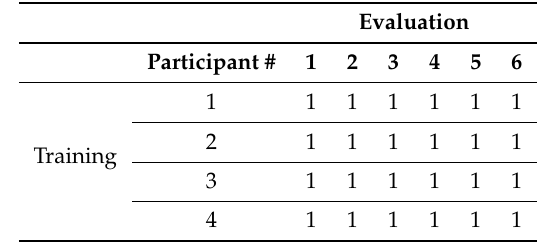
Table 6. Accuracy rates for each combination of training and evaluation participants. Results were obtained through the use of Euclidean distance minimization on RSS data from a 15-node 433 and 868 MHz network.